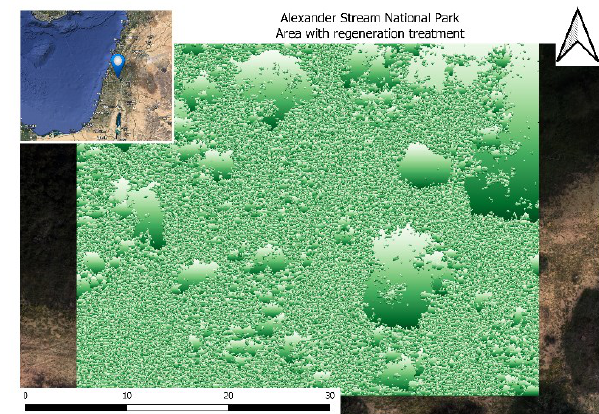
Figure 4. Example of LSMS-Segmentation algorithm result. The green objects are vector polygons of the Alexander Stream National Park subject to regeneration